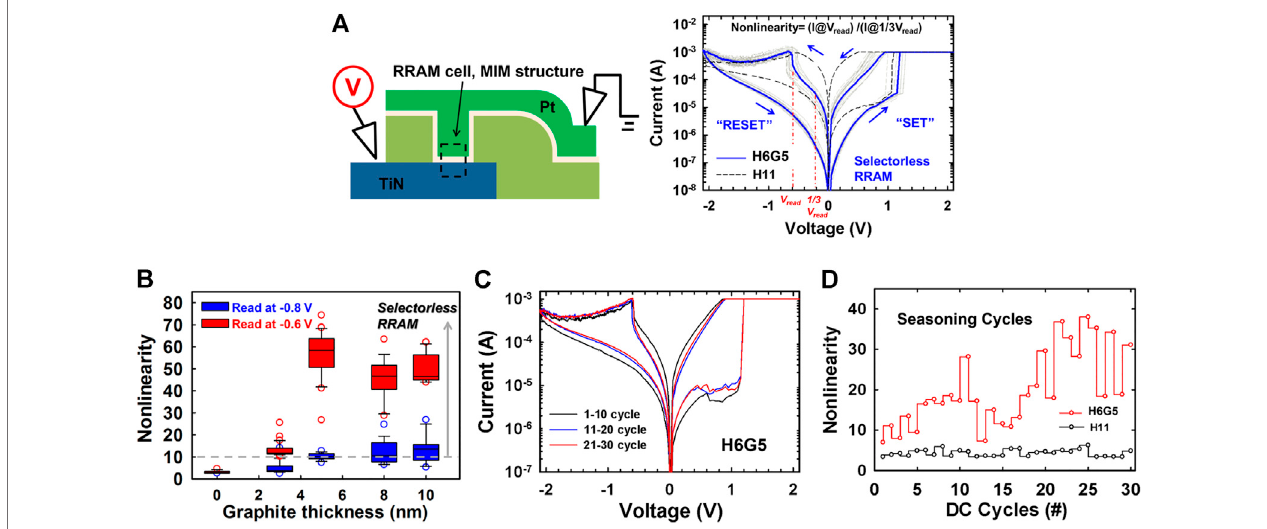
FIGURE1|(A) DevicestructureandI-VcharacteristicsforselectorlessRRAMwithV/3readscheme, (B) non-linearityasafunctionofgraphitethickness(0,3,5,8, and 10 nm), (C) seasoning cycles for a pristine device, (D) non-linearity as a function of seasoning cycles for as-fabricated devices (i.e., H6G5 and H11).